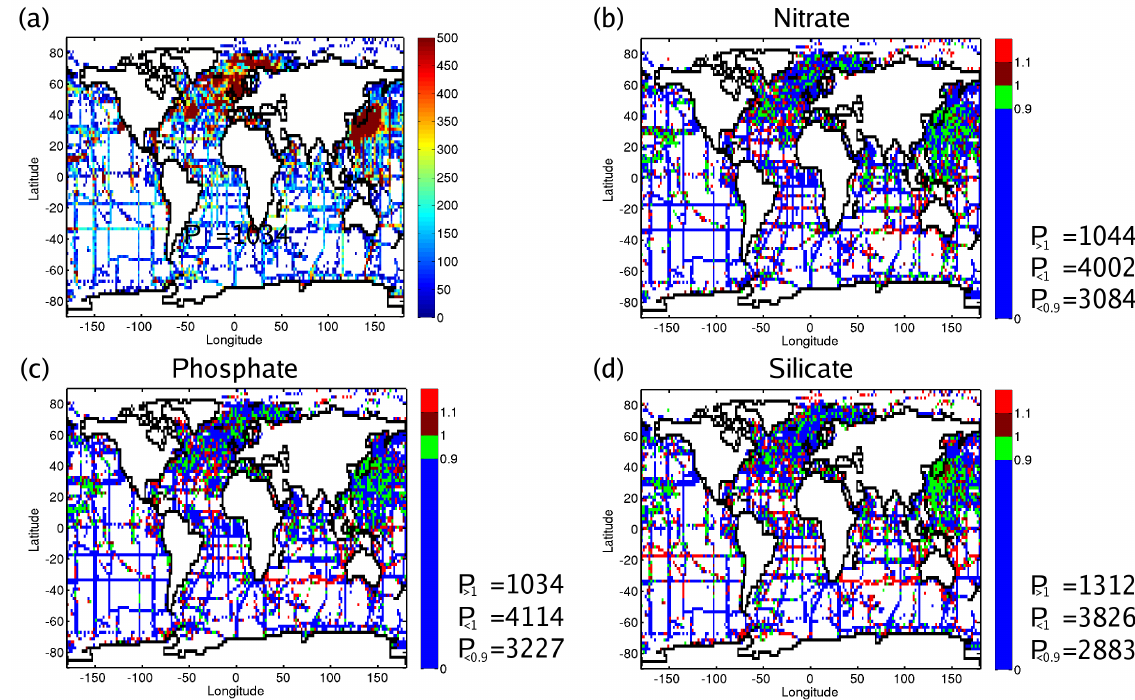
Fig. 2. The value of R , see text, gridded into 2 ◦ bins. The nutrients shown are (b) Nitrate, (c) Phosphate, and (d) Silicate. (a) Shows the number of data points available per 2 ◦ × 2 ◦ bin to estimate R . The plots were generated from World Ocean Database data measured from 1990 onwards. P < 1 is the number of bins with R < 1, P > 1 is the number of bins with R > 1, while P < 0 . 9 is the number of bins with R < 0 . 9. A non-linear color scale is used to highlight the structure near the critical value of R =